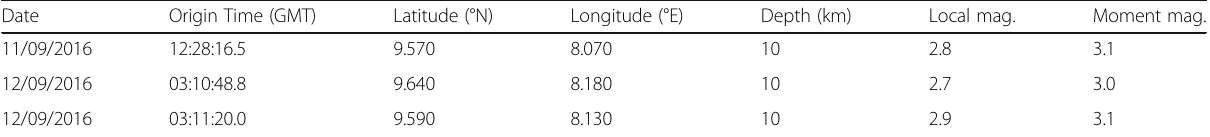
Table 1 Table showing the date, time, depth and magnitudes of the tremors for the area